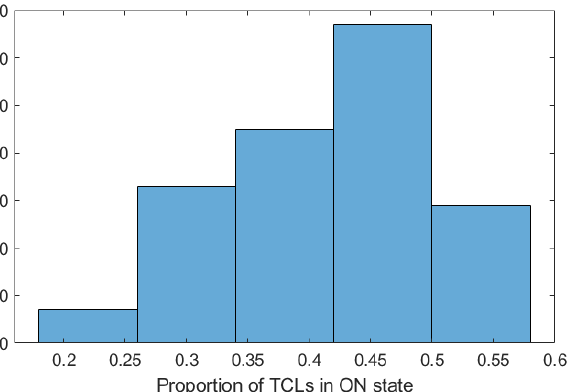
Figure 6. Histogram of TCLs’ (n = 40) proportion that remain ON in a simulated time interval of 200